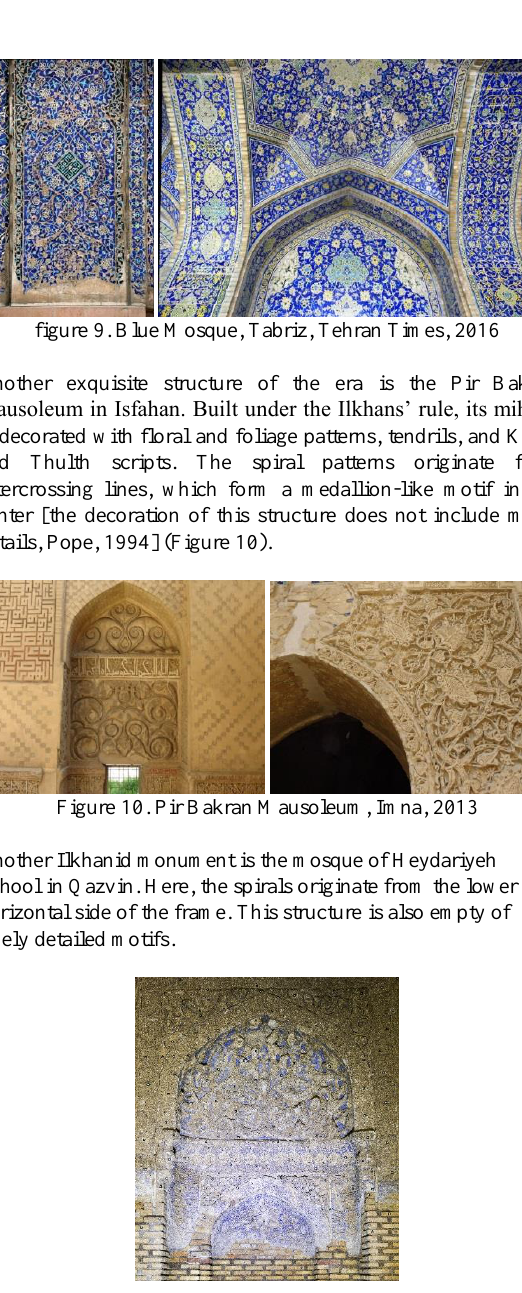
Figure 11. the mosque of Heydariyeh School, author, 2018 2.5 The origin of spiral floral motifs in Iran, from the 10 th or 12 th